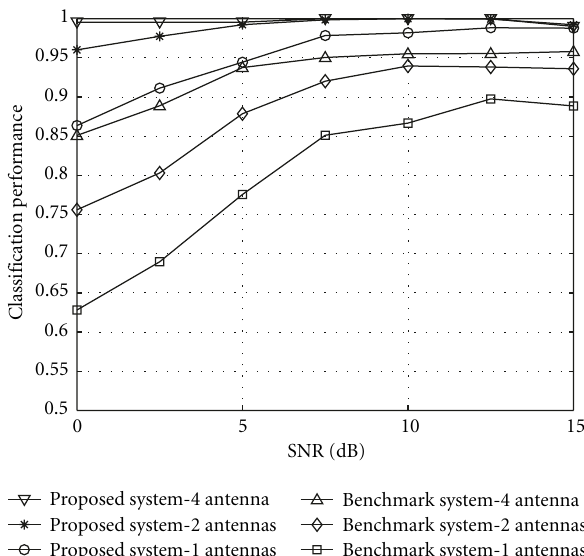
Figure 10: Classification performance of proposed initial SOF- based classification stage and benchmark in a slow flat fading channel using the MRC-variant combining